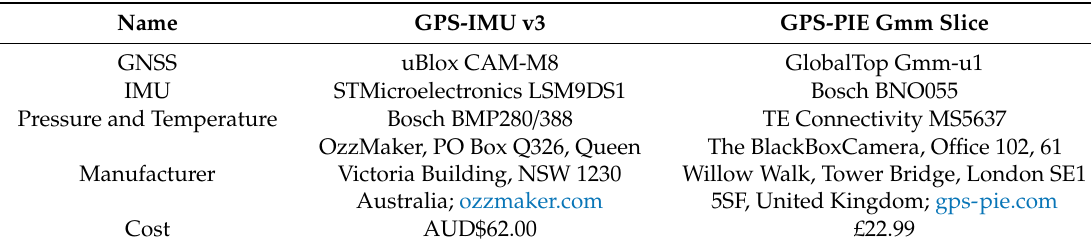
Table 2. Sensor types of the two tested